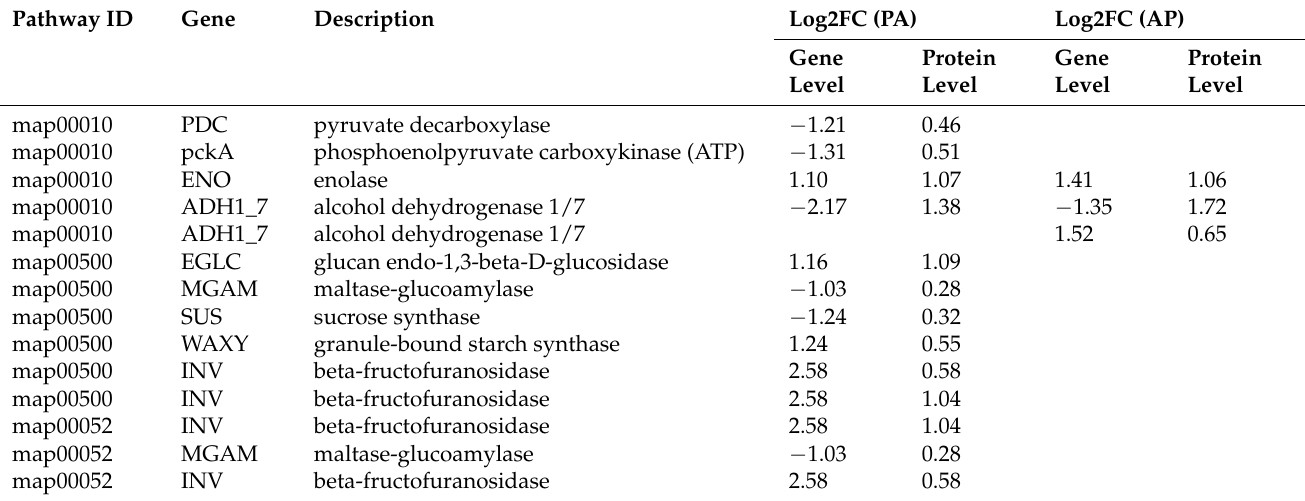
Table 2. Fold change related to the carbohydrate metabolism DEGs/DEPs in peach/apricot (PA) and apricot/peach